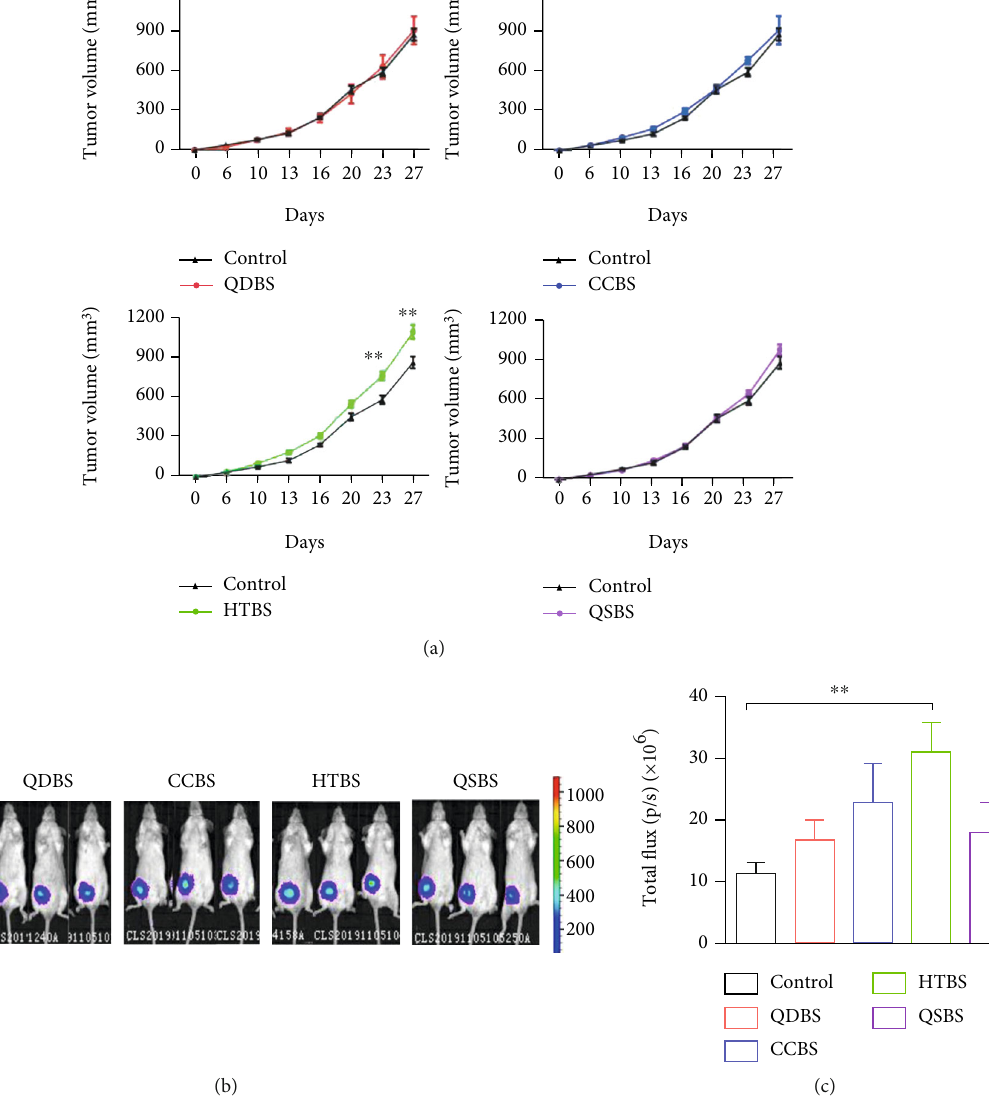
Figure 2: In fl uence of blood stasis syndrome on breast cancer in situ. (a) Tumor volumes were compared between the blood stasis syndrome and control groups. We took the day which tumor cells were injected as day 0, and the tumor grew on day 6. (b) Representative luciferase imaging of mice in the second week after tumor inoculation. (c) Quantitative statistics of tumor in situ fl uorescence image. ∗ P < 0 : 05 and ∗∗ P < 0 : 01 , vs.